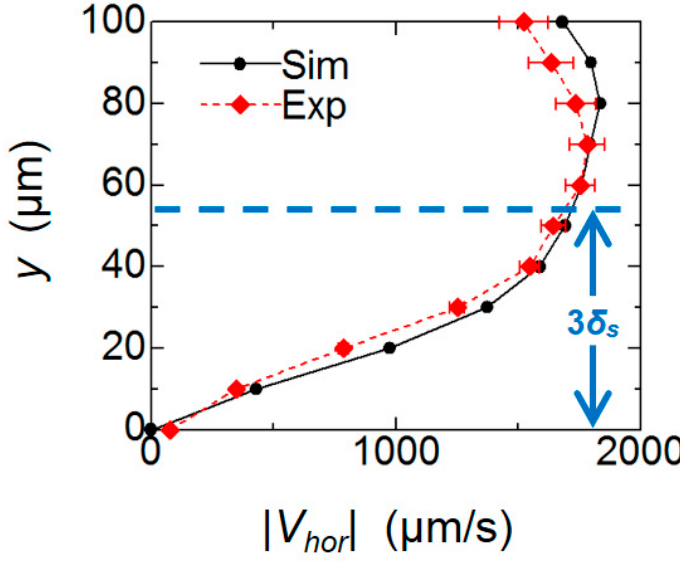
Figure 11. Comparison of vertical distributions of mean horizontal velocity magnitude | V hor |.